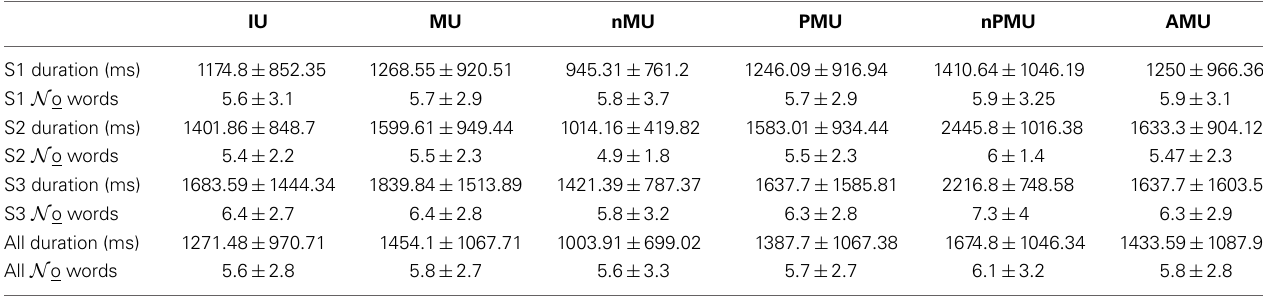
Table 3 | Overview of the length of the different IU